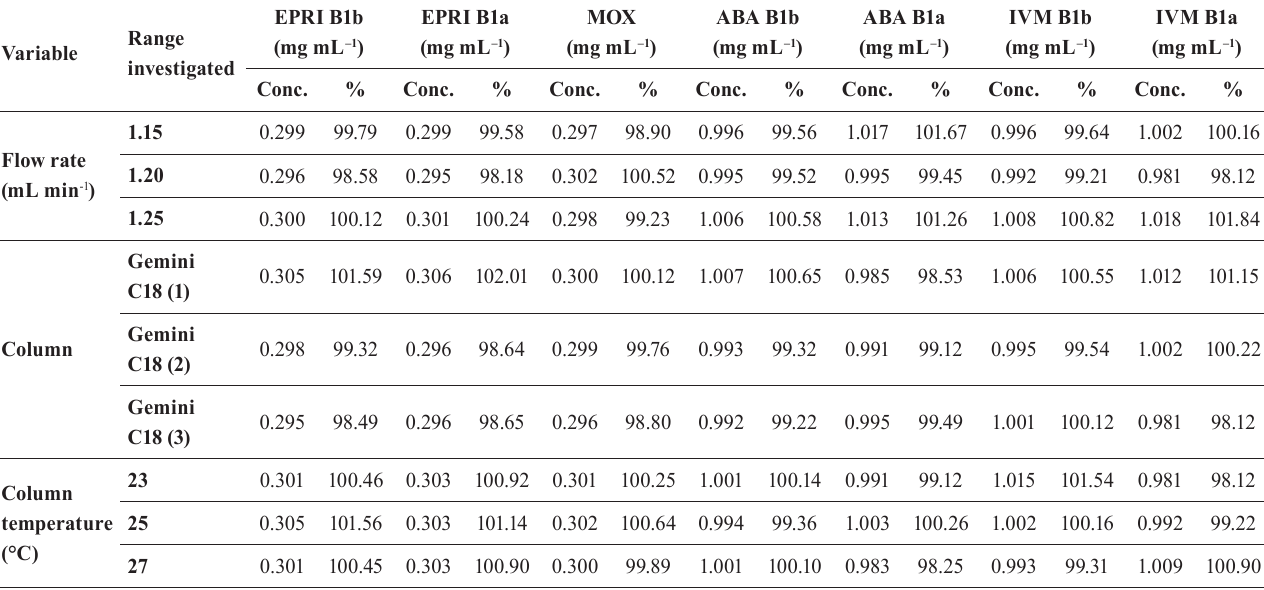
TABLE VII - Chromatographic conditions and range investigated during robustness testing